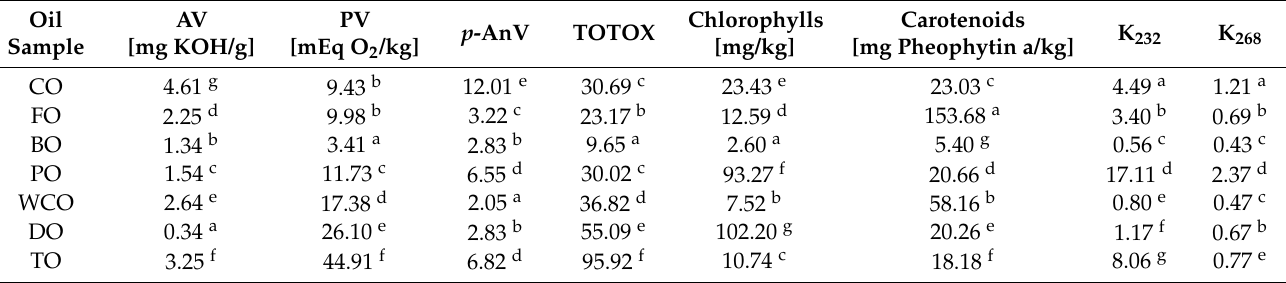
Table 1. Initial quality of analysed cold-pressed